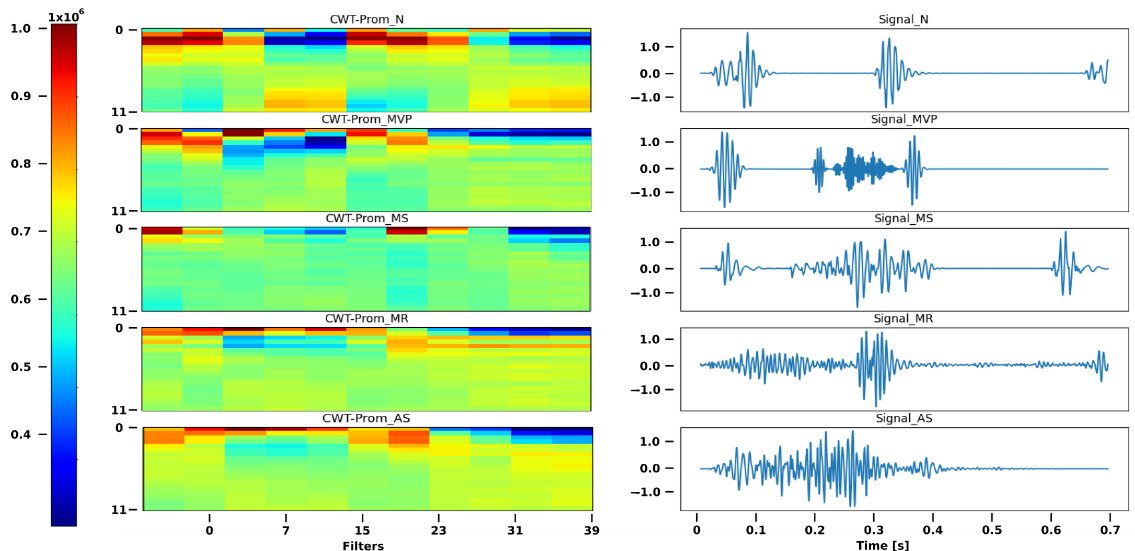
Figure 3. Results after applying MFCCs: The graph on the left shows, in a colorimetric scale, the value of the MFFCs averaged for each of the class sets. The graph on the right shows a normalized PCG record, randomly selected from each of the